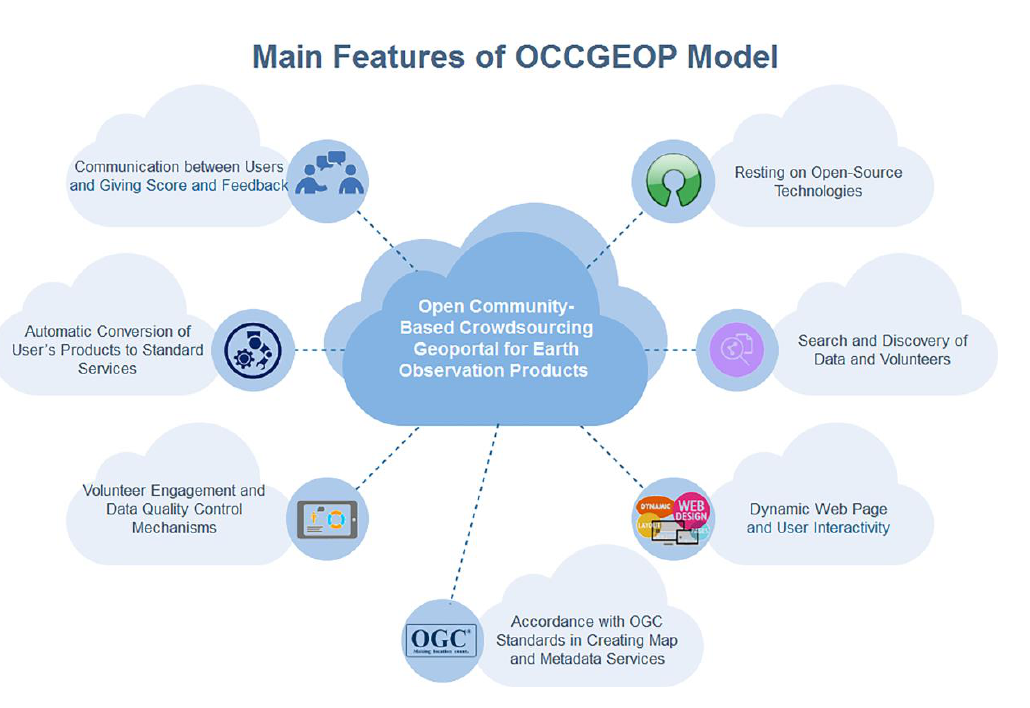
Figure 2. The main features of the OCCGEOP geoportal model.